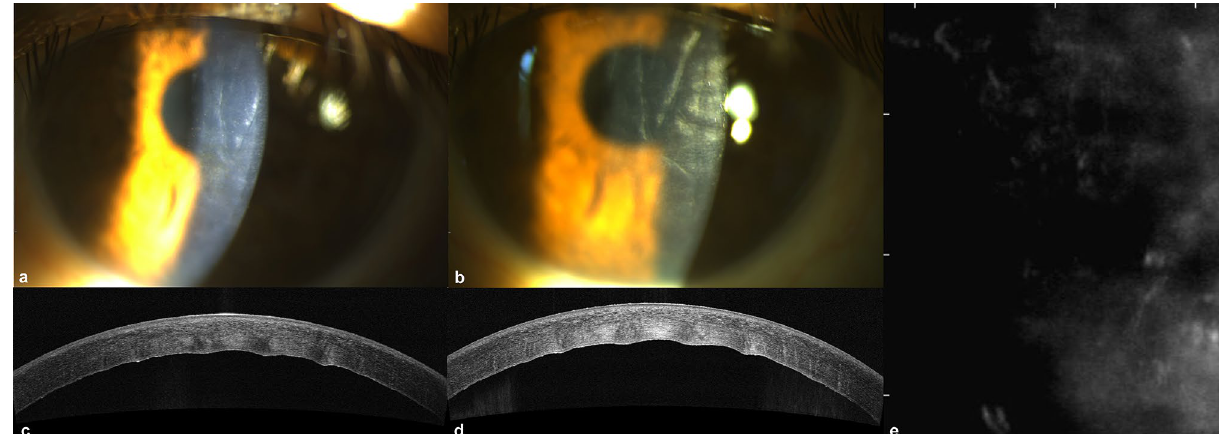
Figure 1. ( a ) External eye photography and ( c ) anterior-segment OCT in a patient with Fuchs’ dystrophy and corneal edema before phacoemulsification surgery. ( b , d ) The same patient after surgery. ( e ) Specular microscopy showed indecipherable endothelial cell density before